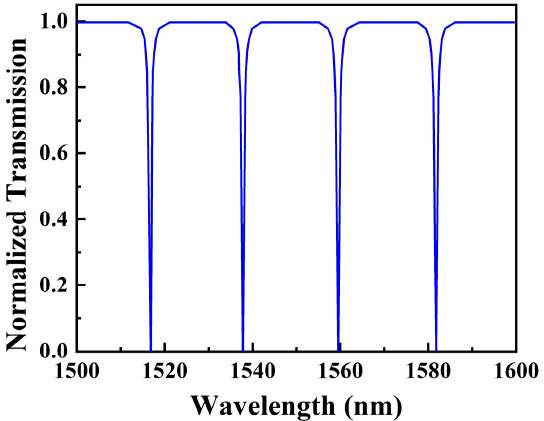
Figure 3. Transmission spectrum of the proposed SMRR with a = Figure 3